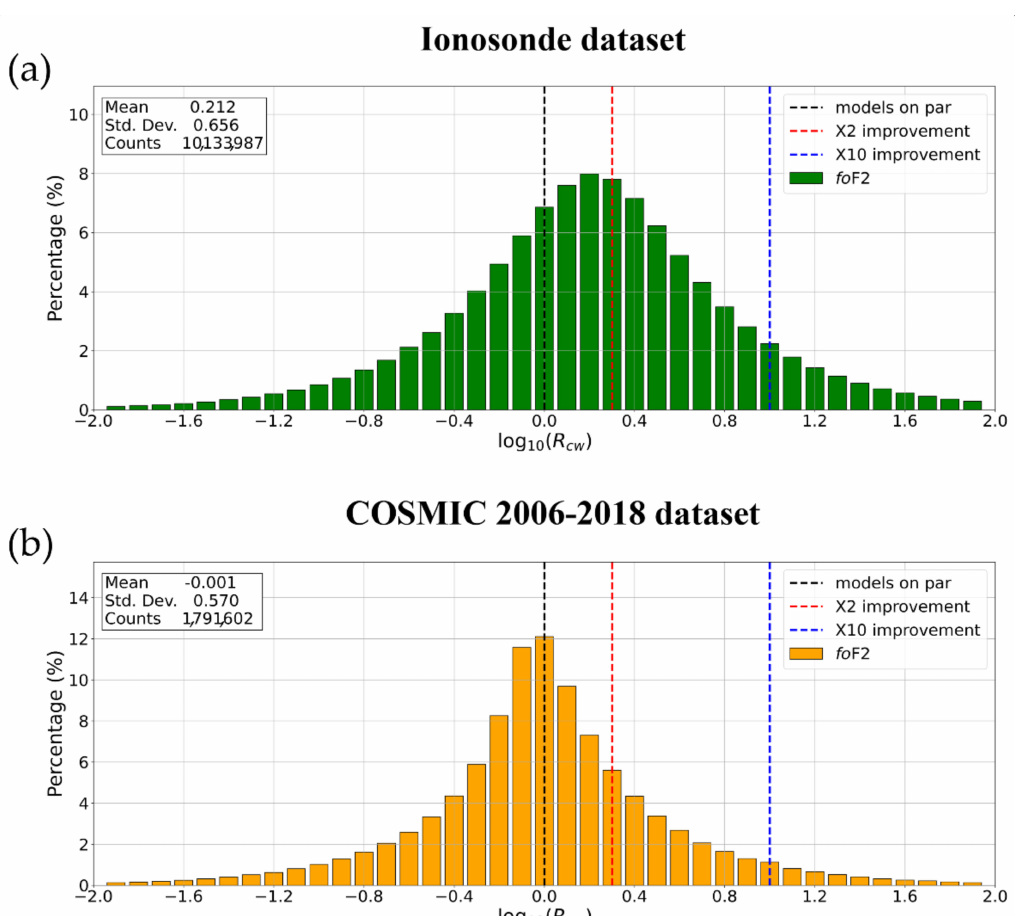
Figure 45. Probability distributions of the residuals’ deviation ratio in a logarithmic scale, log 10 ( R cw ), between IRI and IRTAM models calculated on the ( a ) entire ionosonde and ( b ) COSMIC fo F2 datasets. The mean, standard deviation, and counts values are reported in the upper left corner of each plot. The dashed vertical lines indicate, respectively, when the models are on par (in black), IRTAM improves IRI by a factor of 2 (in red), and IRTAM improves IRI by a factor of 10 (in